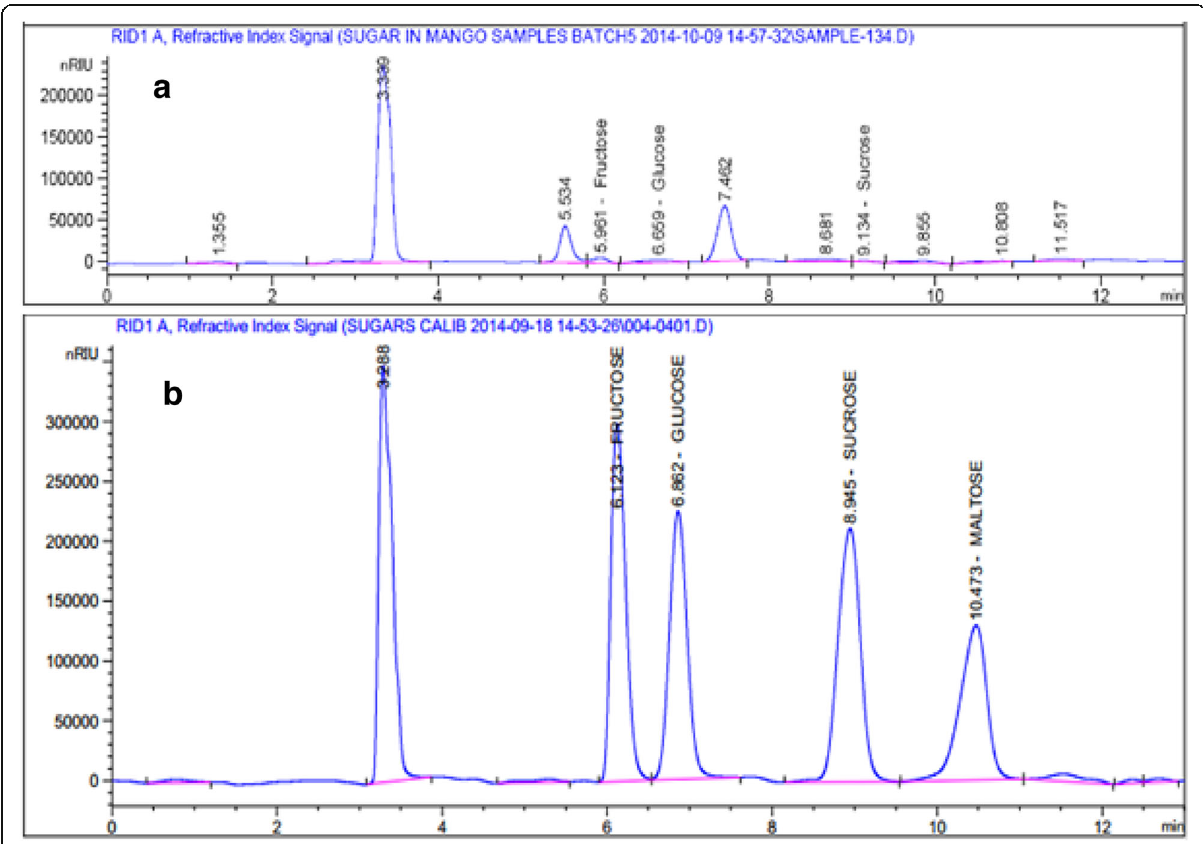
Fig. 1 Example of an HPLC chromatogram of a freeze-dried mango pulp and b four sugar standards for each retention time. a Overlay of raw DRIFT-FTIR spectrum. b Overlay of first derivative DRIFT-FTIR spectrum, acquired from 4000 to 450 cm −